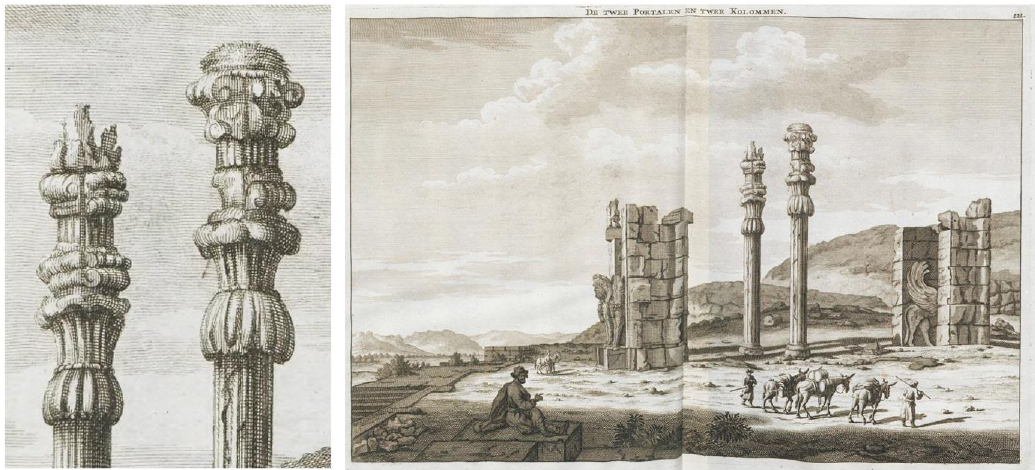
Figure 5. The east–west orientation of the animal motif can be seen in De Bruijn’s drawing. Reference [26] (Fig. 121). Source: Utrecht University Library.